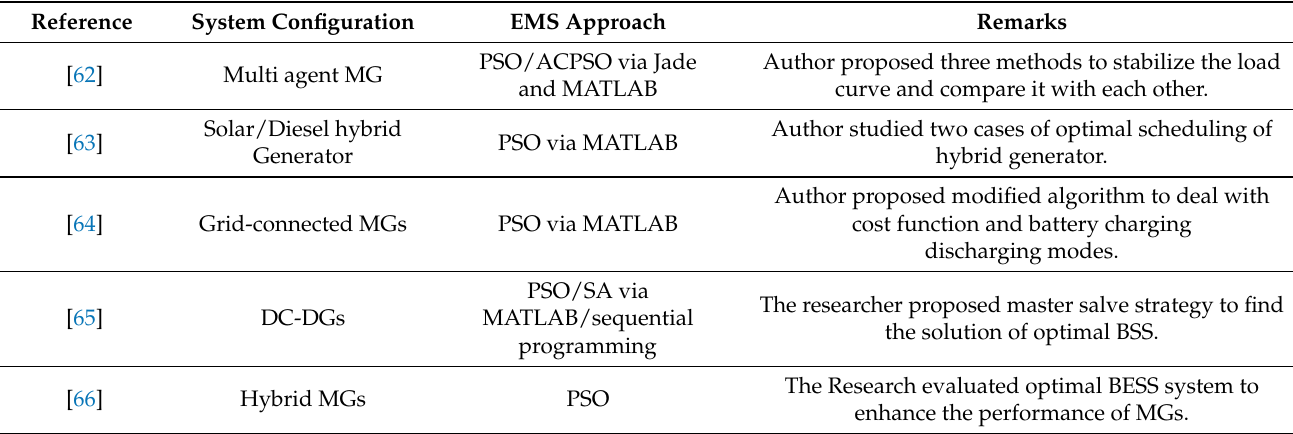
Table 3. A summary of recent studies of EMS based on particle swarm